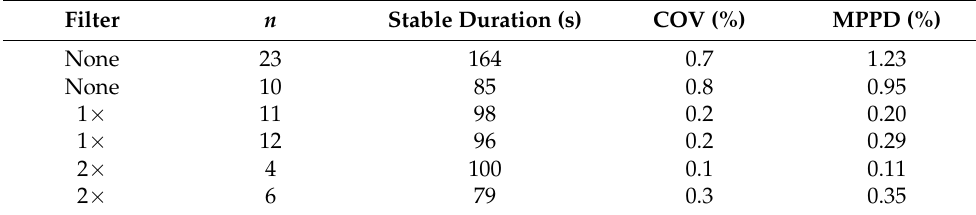
Table 1. Results from the platform monitoring sessions of the solar simulator emissions. Filter n Stable Duration (s)